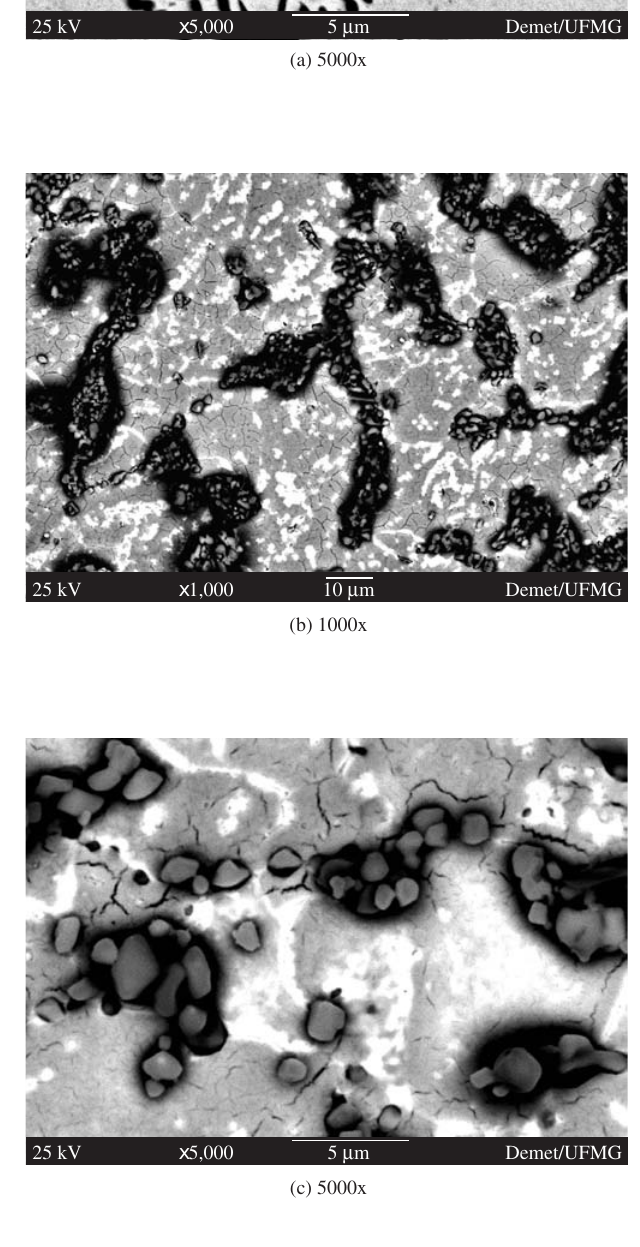
Figure 8. Backscattered electrons image of the region around the antimony rich precipitates in a) the as cast state and b), c) after 2 passes of ECAP processing.